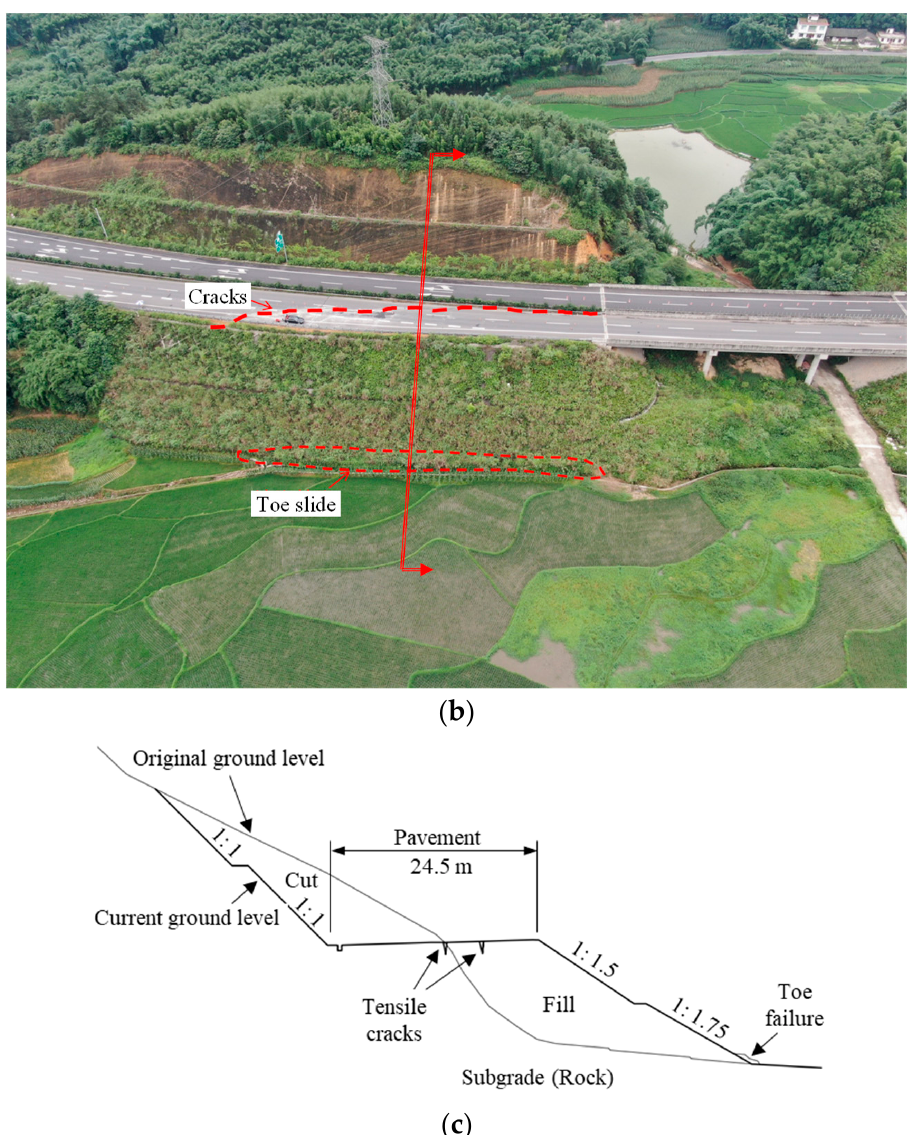
Figure 3. Photo of the typical seismic damage mode of the cut-and-fill sections of chainage K33 + 000-K39 + 000. ( a ) (K34 + 050 ～ K34 + 350). ( b ) K38 + 550 ～ K38 + 750. ( c ) Cross-section of K38 + 650.